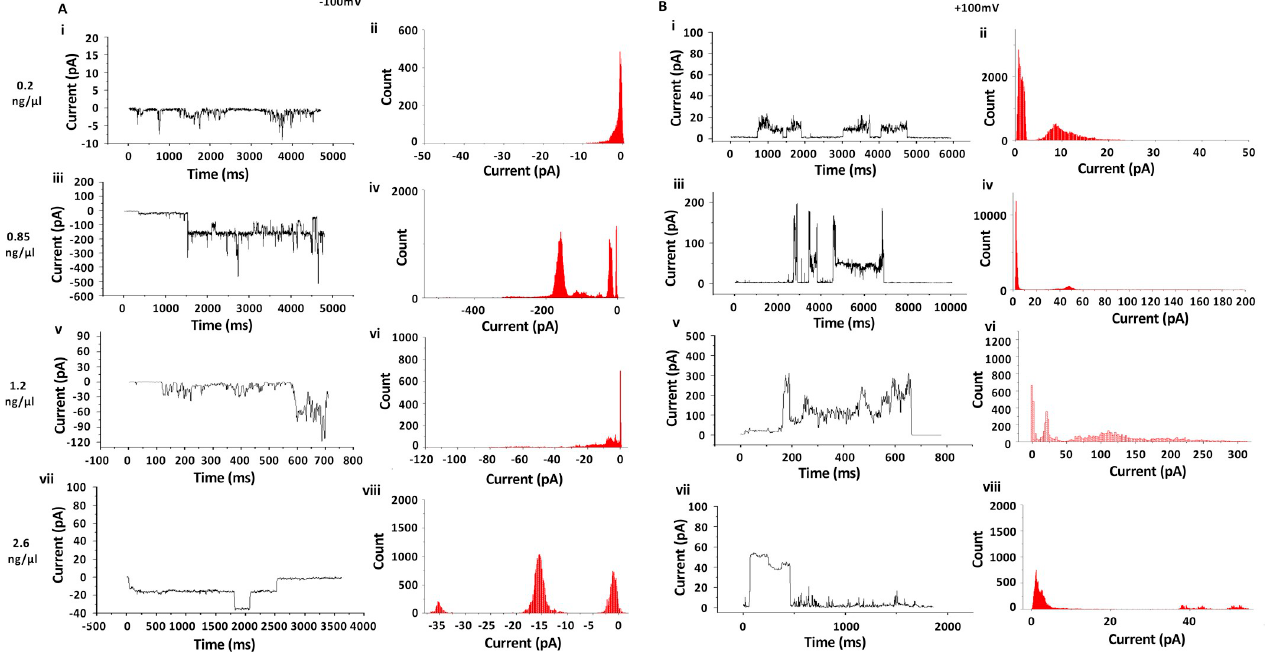
Fig 2. Ion channel activity of GST-6K: (A) and (B) represent ion channel activity of recombinant GST-6K on DPhPC bilayer membrane at applied membrane potentials of - 100mV and +100 mV respectively. The rows from top to bottom represent increasing concentrations of GST-6K (0.2, 0.85, 1.2 and 2.6 ng/ μ l) added to the BLM, whereas in each case the current vs time trace and the corresponding histograms are represented side-by-side (For e.g. Fig 2A—i and